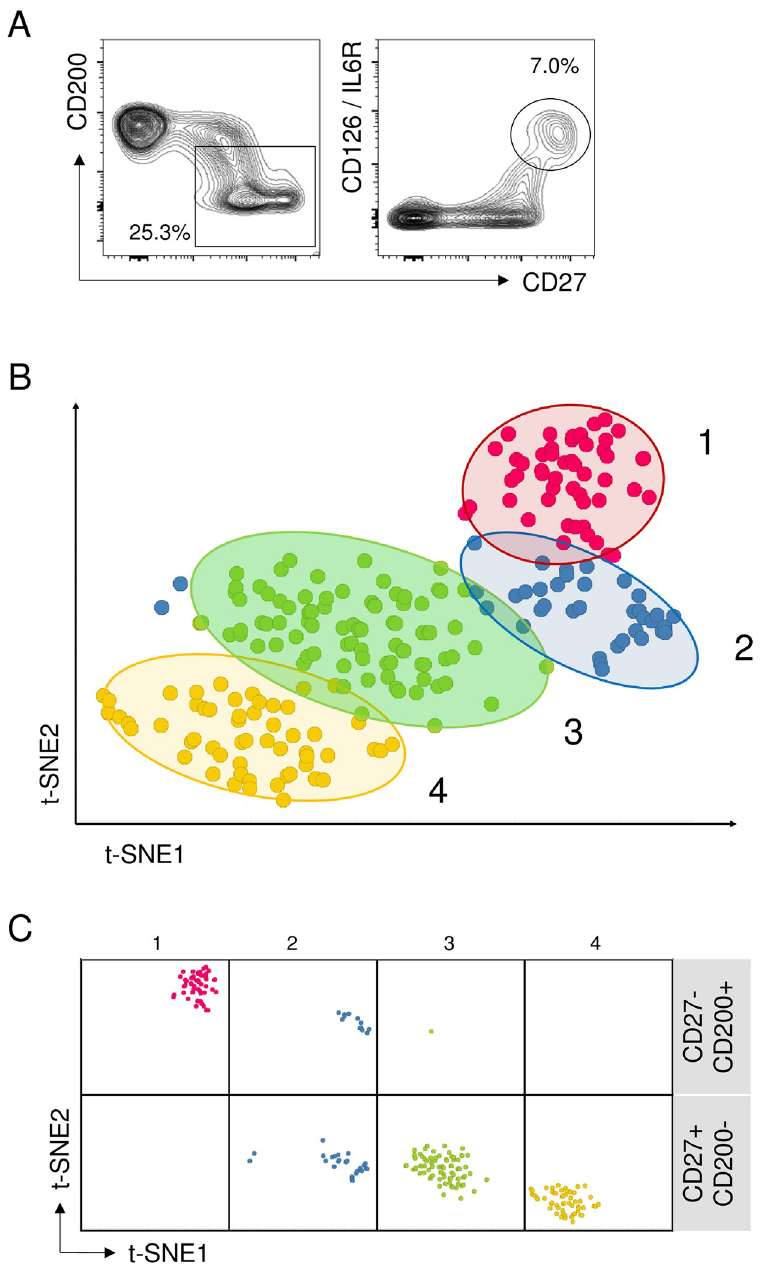
Fig 8. Single cell dissection reveals subsets within the potentially CD8 acceptor B cell pool. (A) IL6R (CD126) is expressed on a small subset of CD19+ cells (right panel), that is only a fraction of the corresponding total CD19+CD27 +CD200- pool (left panel). Numbers indicate the percentage of gated cells within all B lymphocytes. (B) Two- dimensional t-SNE analysis of all single cell events (n = 231) pooled from two apheresis and two PBMC donors; each symbol represents an individual cell. Subsets are numbered and color coded according to their assignment by R-PhenoGraph. Ellipses represent the 95% confidence interval for each color matched population. (C) The single cell– based subsets resolved according to their phenotypic (FACSort) origin, using the same t-SNE and R-PhenoGraph annotation as in (B).